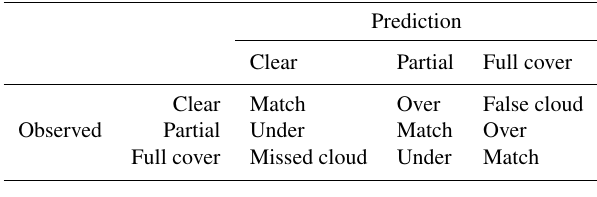
Table 5. The five possible outcomes for the detection of predicted cloud cover compared to observation, where 0%–5%, 5%–95%, and 95%–100% are defined as clear, partial, and full cover, respec- tively. In addition to the classifications of match, miss, false/over- prediction in the detection method for binary condition, we have partial matches of “under” and “over”.